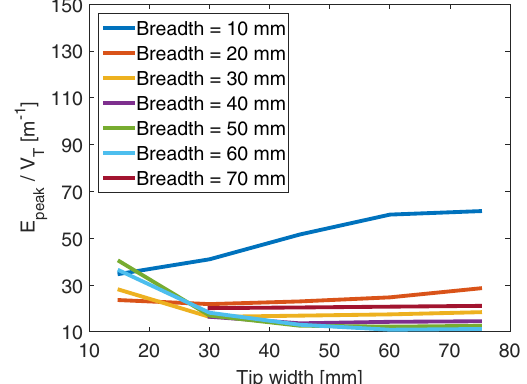
=V FIG. 8. E T vs tip width for different values of tip breadth. peak The base width and breadth were fixed at 110 mm and 65 mm, respectively.